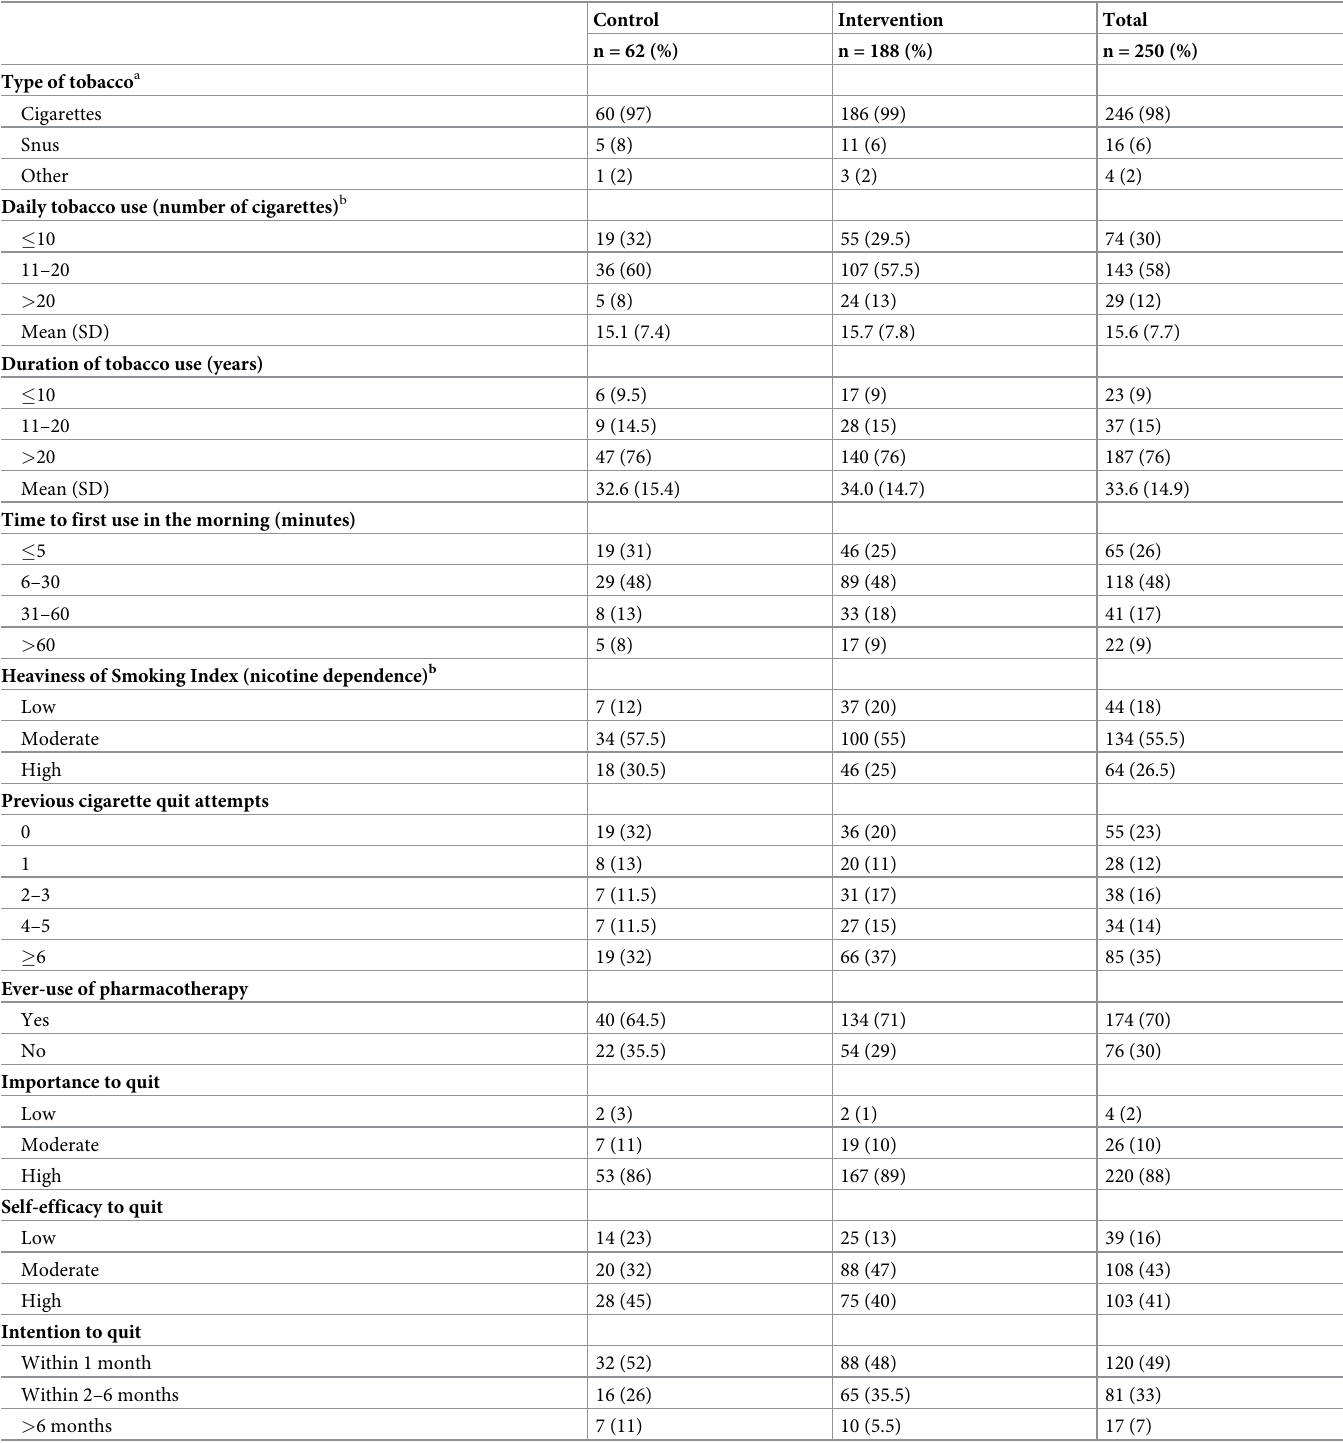
Table 2. Patients’ tobacco use at baseline.